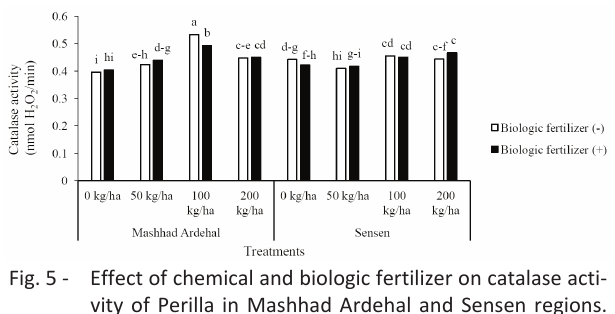
Fig. 5 - Effect of chemical and biologic fertilizer on catalase acti- vity of Perilla in Mashhad Ardehal and Sensen regions. Different letters in each column denote a significant dif- ference at p≤0.05 (LSD test).